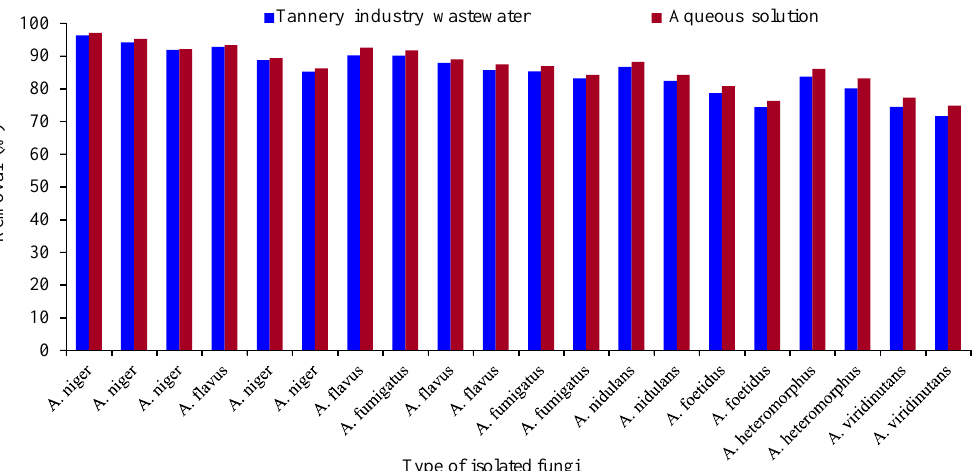
Fig. 4: The maximum removal percentage Cr(VI) in a tannery industry wastewater and in an aqueous solution by an isolated fungi with an optimum pH of 3, optimum incubation time of 7 days, optimum fungus biomass of 4.0 g and an initial Cr(VI) concentration of 18.125